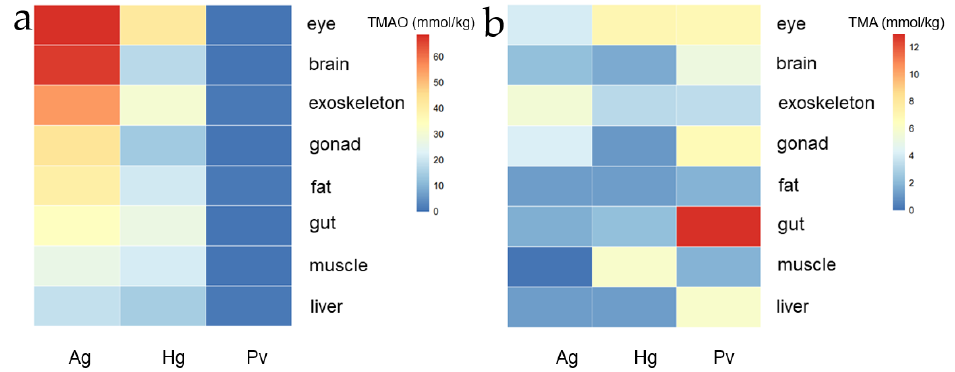
Figure 3. (a-b) TMAO and TMA concrete content in eight tissues (eye, brain, muscle, exoskeleton,